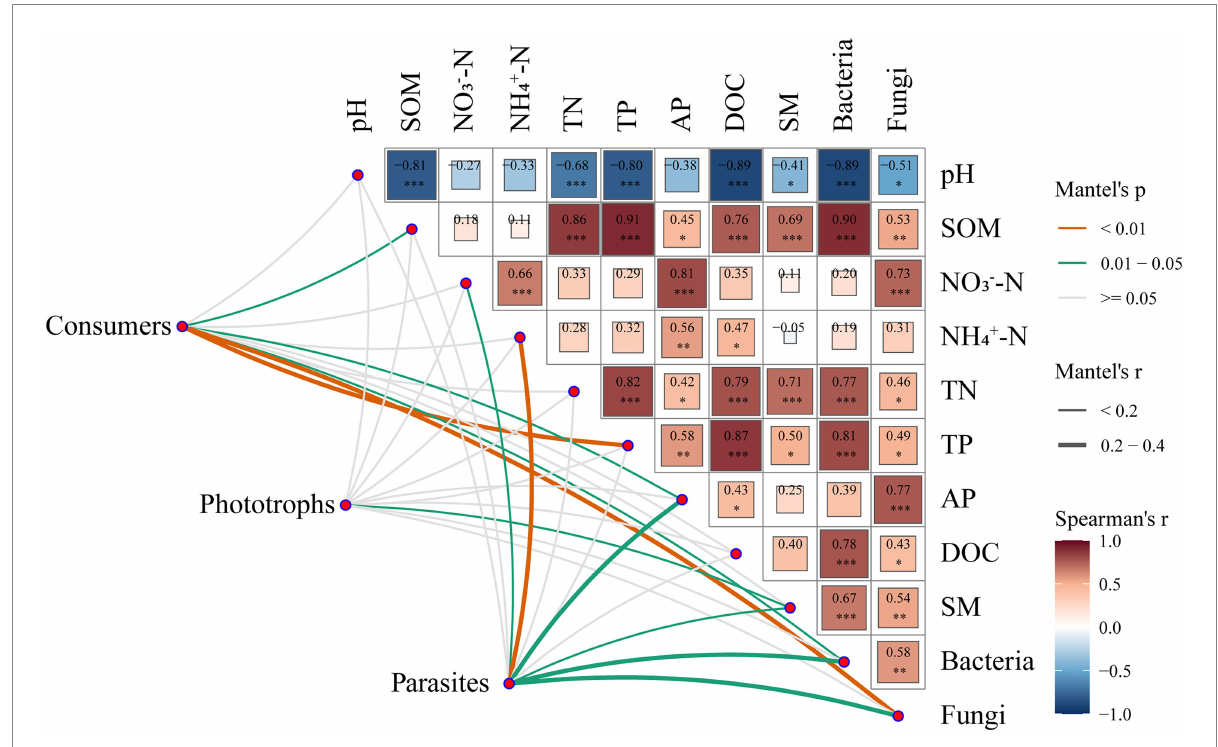
FIGURE 3 Pairwise comparisons of biotic and abiotic factors are shown, with a color gradient denoting Spearman’s correlation coefficients. Protistan functional groups were related to each biotic and abiotic factor by Mantel tests. The edge width corresponds to Mantel’s r statistic for the corresponding distance correlations, and the edge color denotes the statistical significance based on 9,999